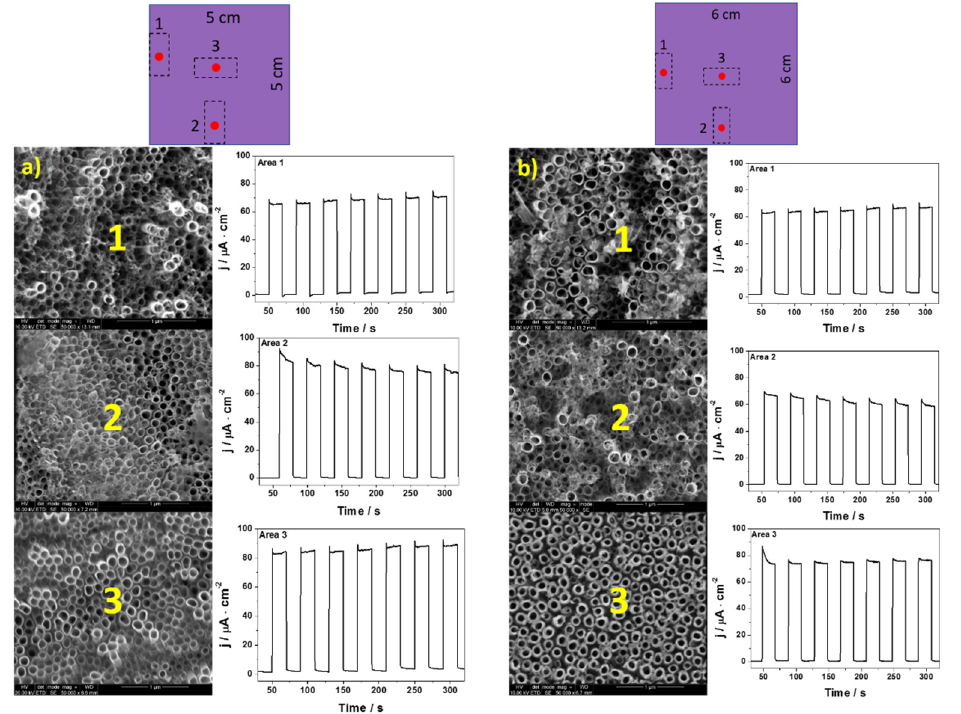
Figure 5. Transient photocurrent responses and SEM at various places on the ( a ) TN25 and ( b ) TN36.